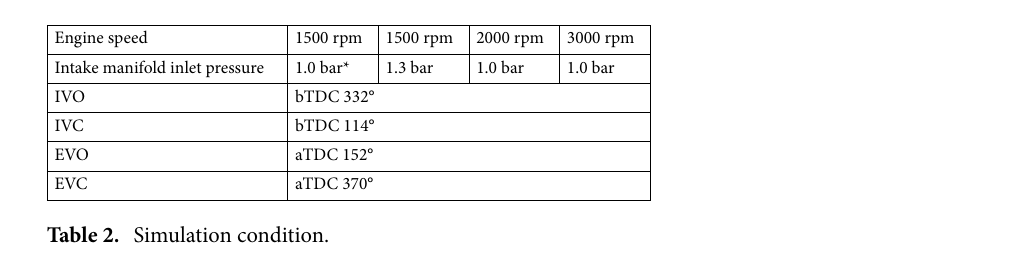
Table 2. Simulation condition.